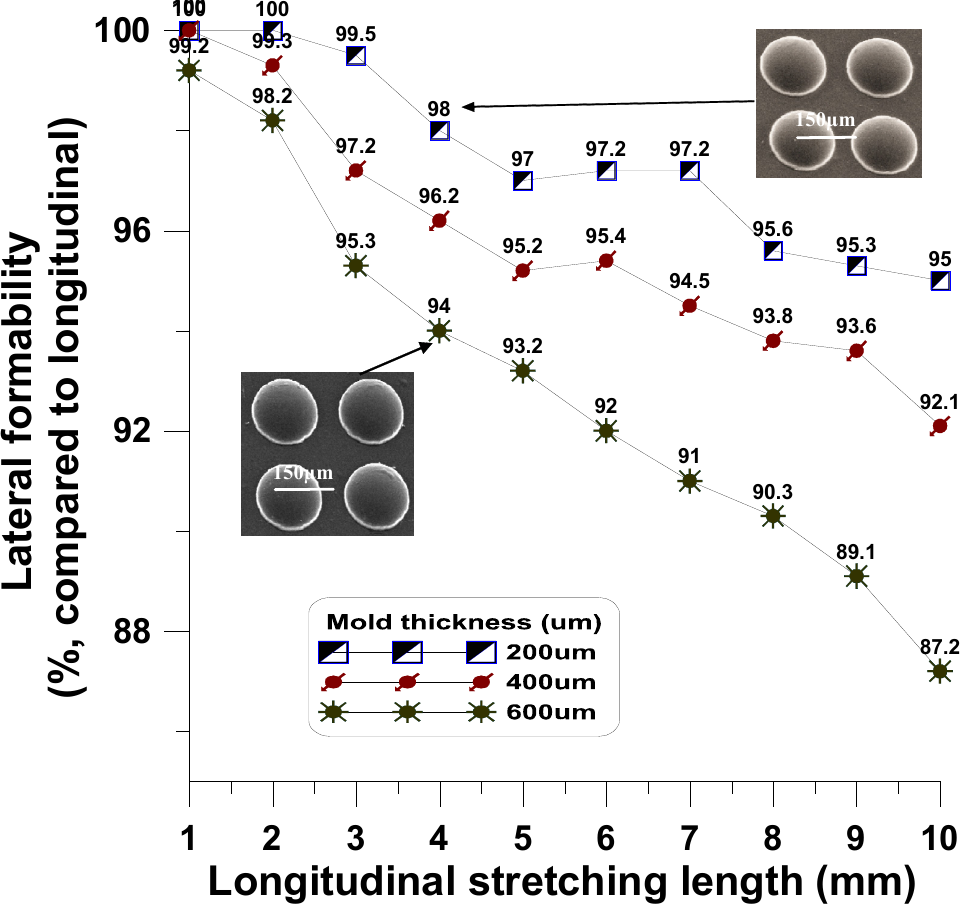
Figure 19. Formability of microstructure molds with different thicknesses in the uniaxial dynamic NPR microstructure mold replication.